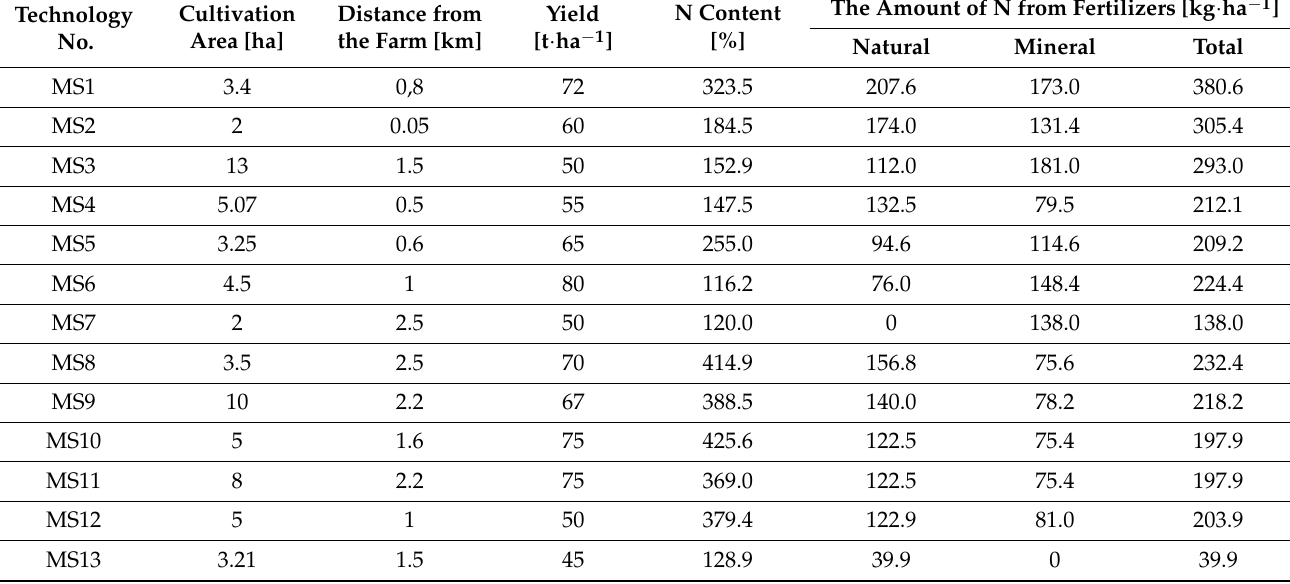
Table 5. Selected technology-specific elements.